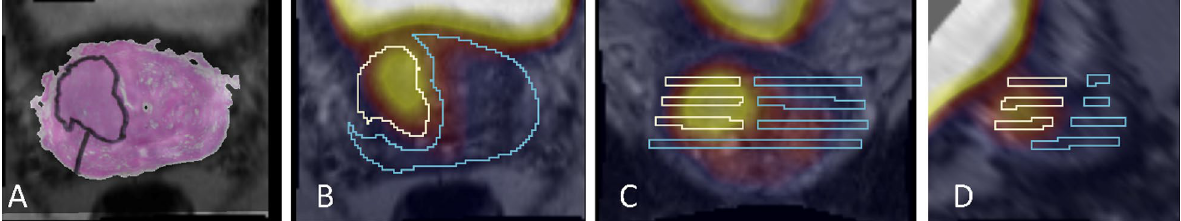
Fig. 1 Co-registered imaging data for patient 26 showing a histology and T2w MRI with tumour annotated by a pathologist, and b – d axial, coronal and sagittal (respectively) T2w MRI aligned with PET showing tumour voxels defined from histology outlined in white and benign voxels defined as being 3.3 mm beyond the tumour voxel boundary outlined in